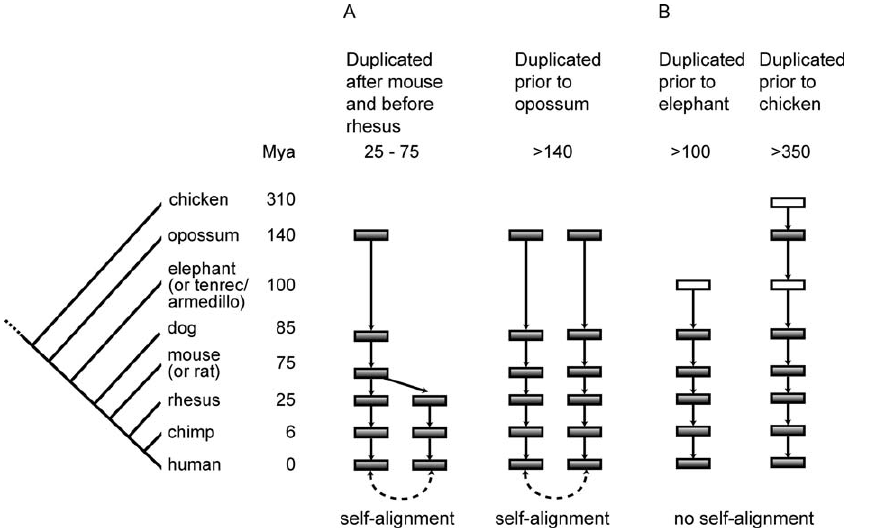
Figure 4. Timing of Gene Birth Is Estimated by Determining Duplication Histories of Genomic Regions Surrounding the Gene Losses For the subset of gene losses with detectable human self-alignment, the duplication branch is determined by tracing each duplicate of the best human self-alignment through a seven-species syntenic genomic alignment. For those without detectable self-alignments, the duplication branch is determined by the seven-species syntenic alignments plus alignments with the chicken genome, and the elephant, tenrec, and armadillo scaffolds when available. Filled rectangles represent syntenic alignment to the human genome, and open rectangles represent genomes or scaffolds aligned to the human genome without the syntenic constraint. Approximate time when the species diverged from the human lineage is shown in Mya.